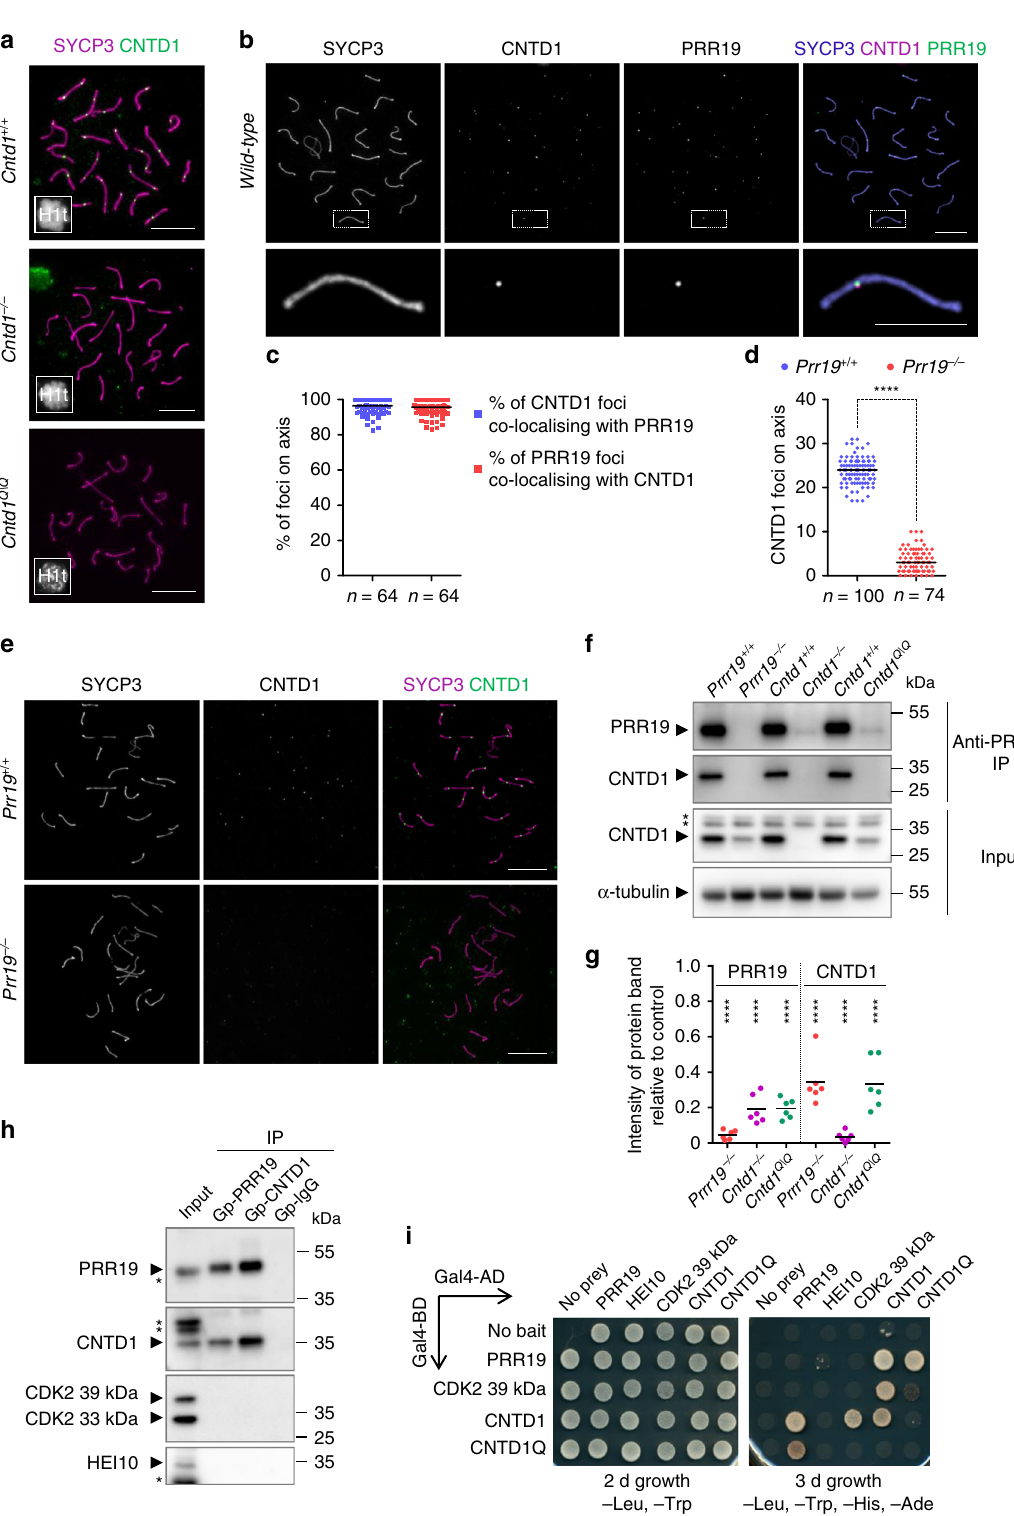
Recombination defects that lead to autosomal asynapsis cause a redistribution of HORMAD1-HORMAD2-ATR from sex chro- mosomes to asynaptic autosomes 33,35,53,54 . This diminishes the silencing of sex chromosomes 53 , which permits expression of genes that are deleterious for mid pachytene spermatocytes 33,55 . Recombination defects that impair DSB repair are also thought to arrest spermatocytes in early pachytene via a mechanism that